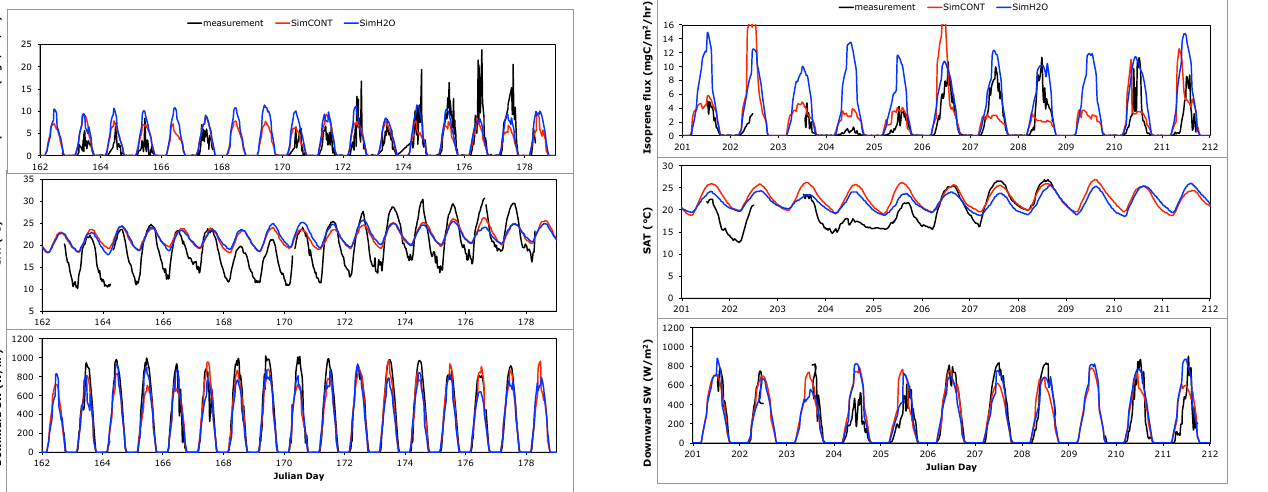
Figure 8d. Results for Harvard Forest during July 20-31 2007. Fig. 8d. (a–e) Time evolution of isoprene emission flux, surface air temperature (SAT) and downward shortwave (SW) radiation at the temperate measurement sites. Measurements are shown in black (where data is available). Model climatological results are averages of 10 simulation years in SIMCONT (red) and SimH2O (blue). (d) Harvard Forest during 20–31 July